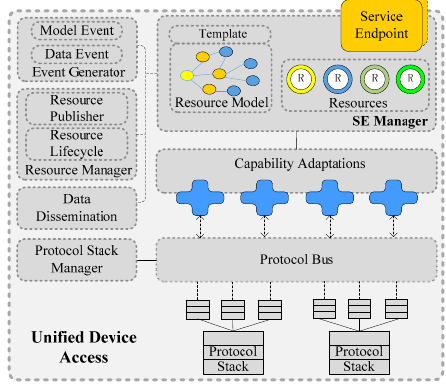
Figure 3. Internal structure of UDA.